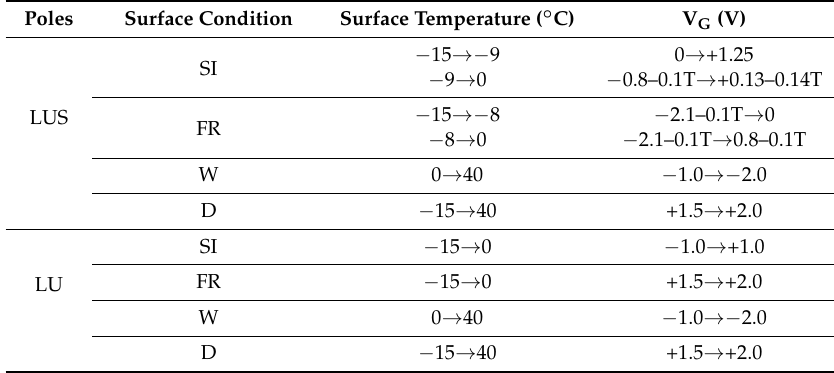
Table 1. Voltage–temperature zones for various